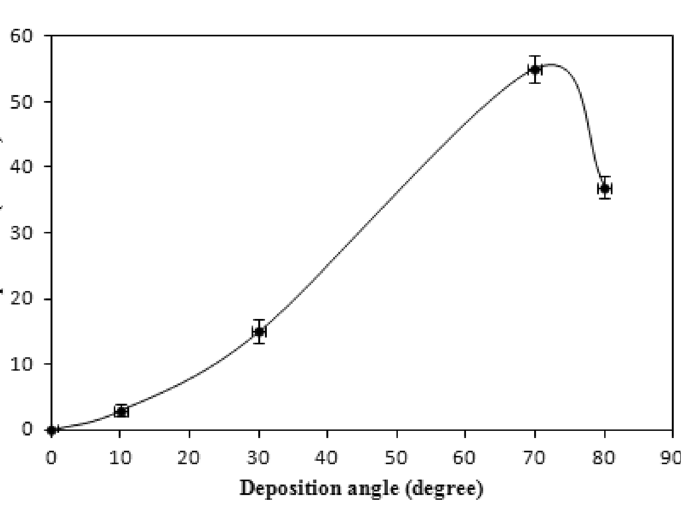
Figure 12. Responsivity versus deposition angle behavior of Sb detectors; irradiated with CO 2 laser